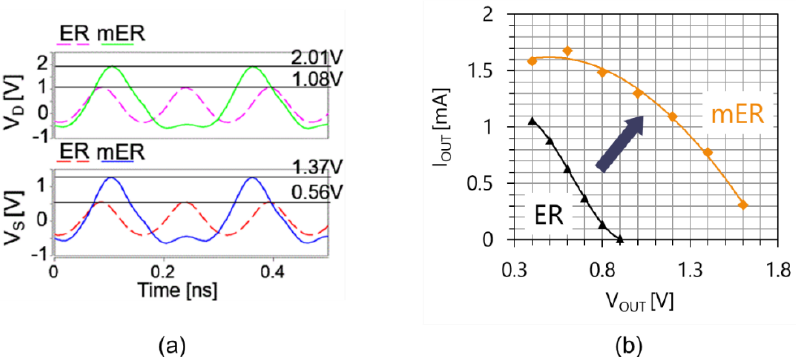
Figure 4. Comparison of mESCO with ESCO; ( a ) waveform of V D and V S when the outputs are open, ( b ) V OUT − I OUT .